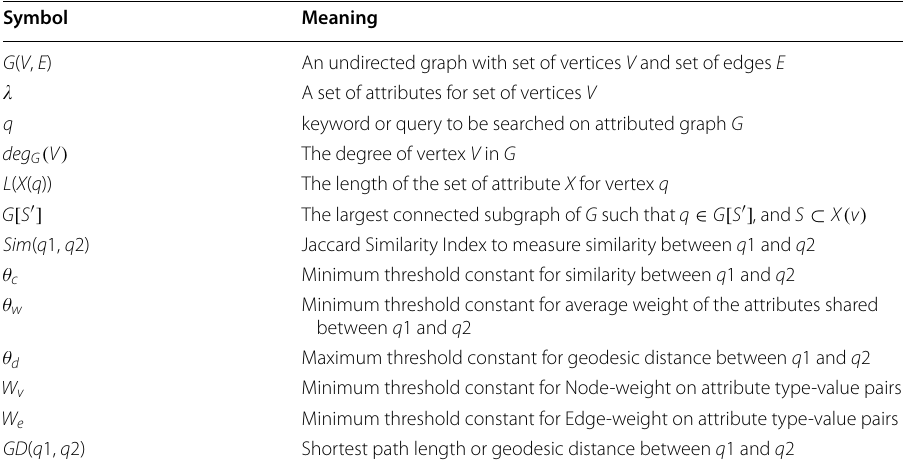
Table 1 Symbols and meanings Symbol Meaning G ( V , E ) An undirected graph with set of vertices V and set of edges E (cid:31) A set of attributes for set of vertices V q keyword or query to be searched on attributed graph G deg G ( V ) The degree of vertex V in G The length of the set of attribute X for vertex q G [ S ′ ] The largest connected subgraph of G such that q ∈ G [ S ′ ] , and S ⊂ X ( v ) Sim ( q 1, q 2) Jaccard Similarity Index to measure similarity between q 1 and q 2 θ c Minimum threshold constant for similarity between q 1 and q 2 Minimum threshold constant for average weight of the attributes shared between q 1 and q 2 Maximum threshold constant for geodesic distance between q 1 and q 2 Minimum threshold constant for Node-weight on attribute type-value pairs Minimum threshold constant for Edge-weight on attribute type-value pairs Shortest path length or geodesic distance between q 1 and q